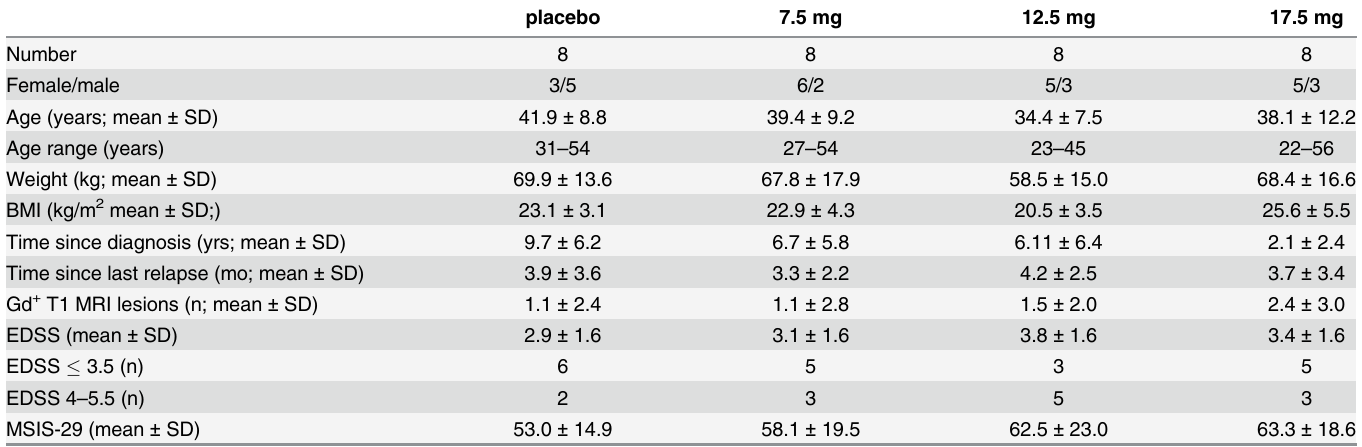
Table 2. Phase IIa study baseline characteristics.